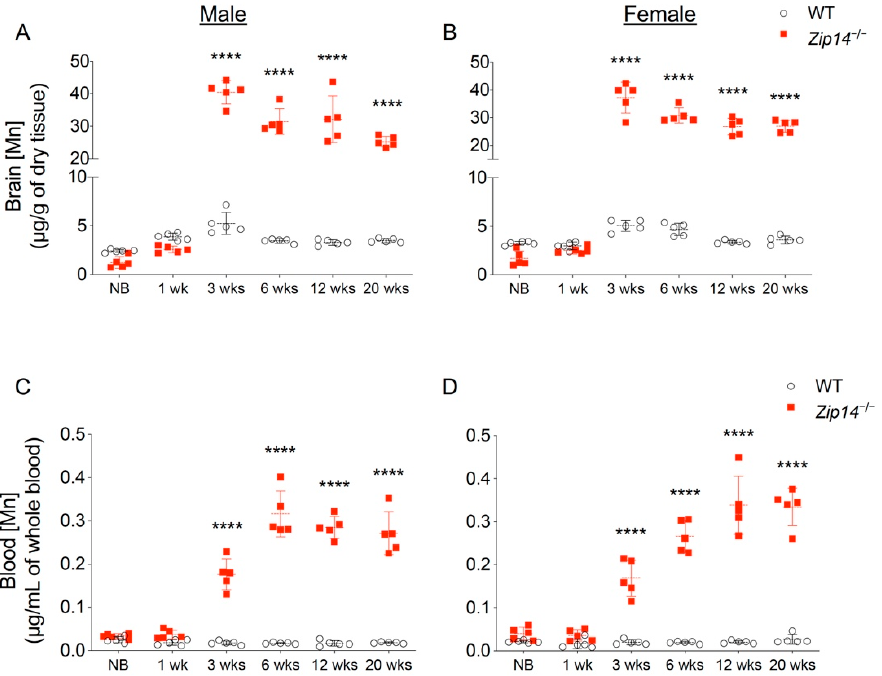
Figure 1. Brain and blood manganese concentrations in mice from different age groups of wild-type (WT) and Zip14 knockout ( Zip14 − / − ) mice. ( A , B ) Brain and ( C , D ) blood manganese (Mn) contents measured by inductively coupled plasma mass spectrometry (ICP-MS) in male and female mice at newborn (NB), 1 week (1 wk), 3 weeks (3 wks), 6 weeks (6 wks), 12 weeks (12 wks) and 20 weeks (20 wks) of age ( n = 5/group). Data were expressed as mean ± standard deviation (S.D.). Statistical analysis was performed using two-way ANOVA, followed by the Bonferroni post-hoc test to compare the age and sex-matched WT and Zip14 − / − mice. **** p < 0.0001.